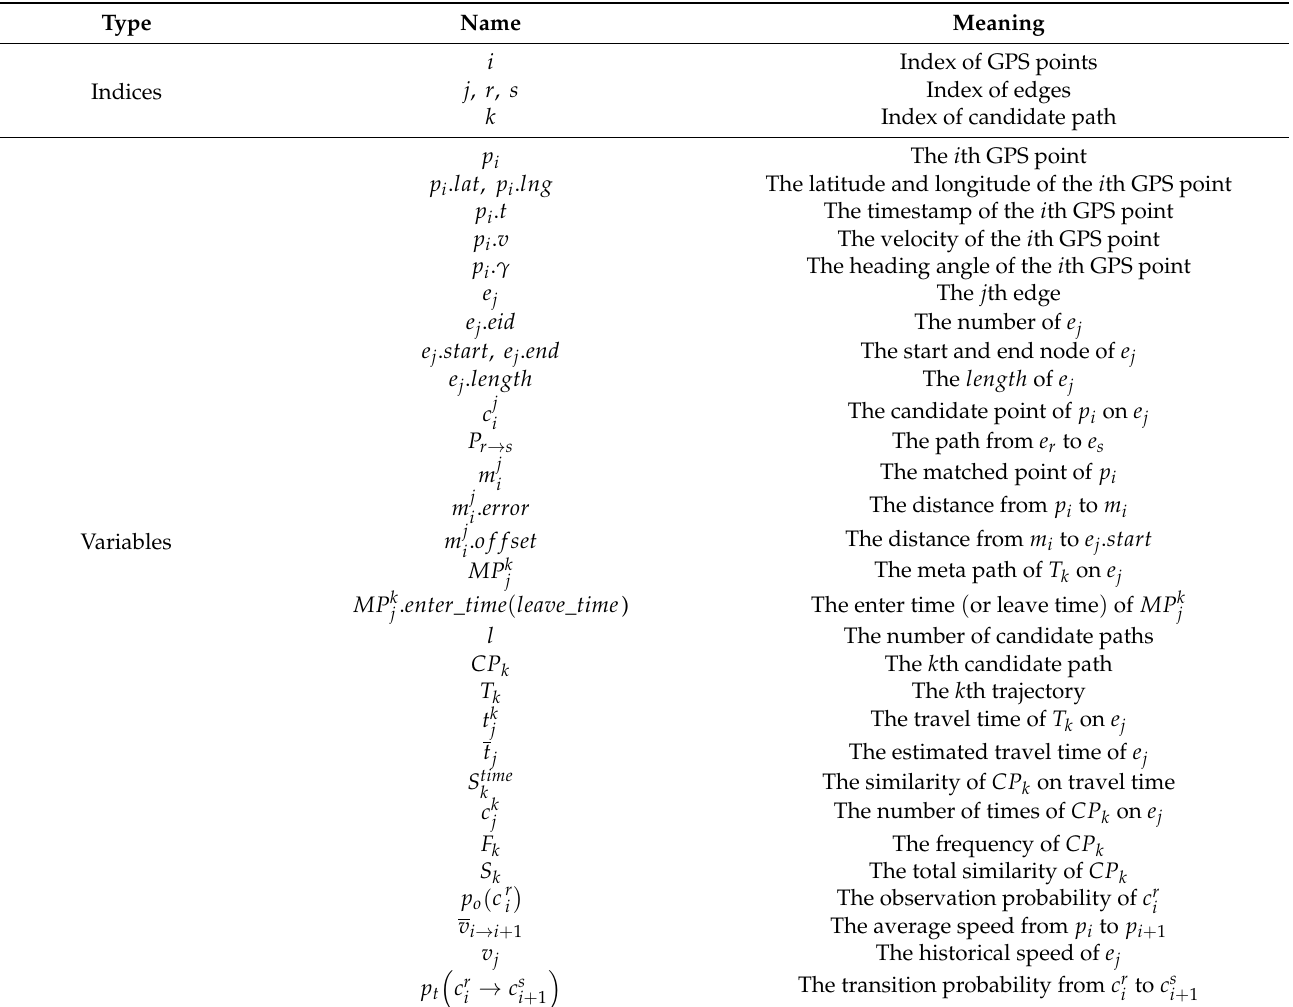
Table 1. Indices and variables for